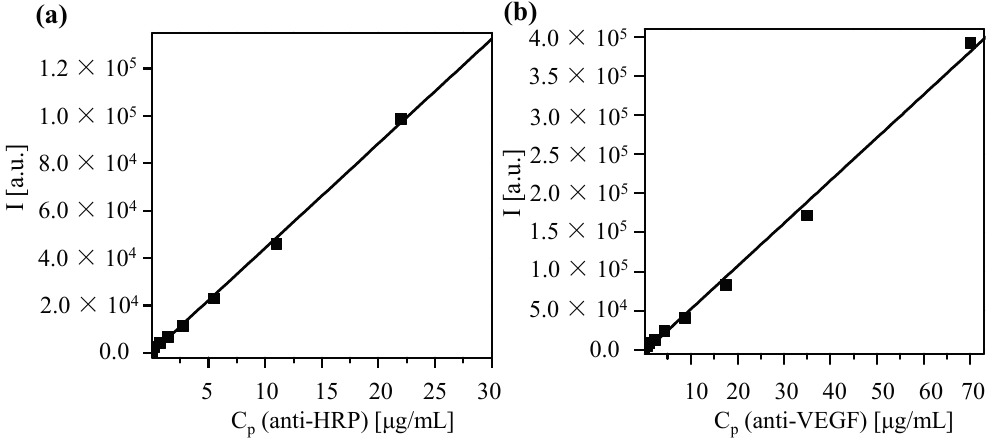
Figure 5. Calibration curve in which the fluorescence intensity I at 519 nm is determined for protein solutions of different concentration C P . Data are shown for antibodies against ( a ) horseradish peroxidase (HRP) and ( b ) vascular endothelial growth factor (VEGF). A linear fit leads to the following correlation between fluorescence intensity I and concentration C P : ( a ) I (C P ) = I 0 + ( Δ I / Δ C P )· C P = − 464.28 + (4447.1 mL/µg)· C P ; ( b ) I ( C P ) = − 3549.4 + (5498.3 mL/µg)· C P . The coefficients of determination ( r 2 ) are equal to 0.998 and 0.995 for HRP and VEGF,